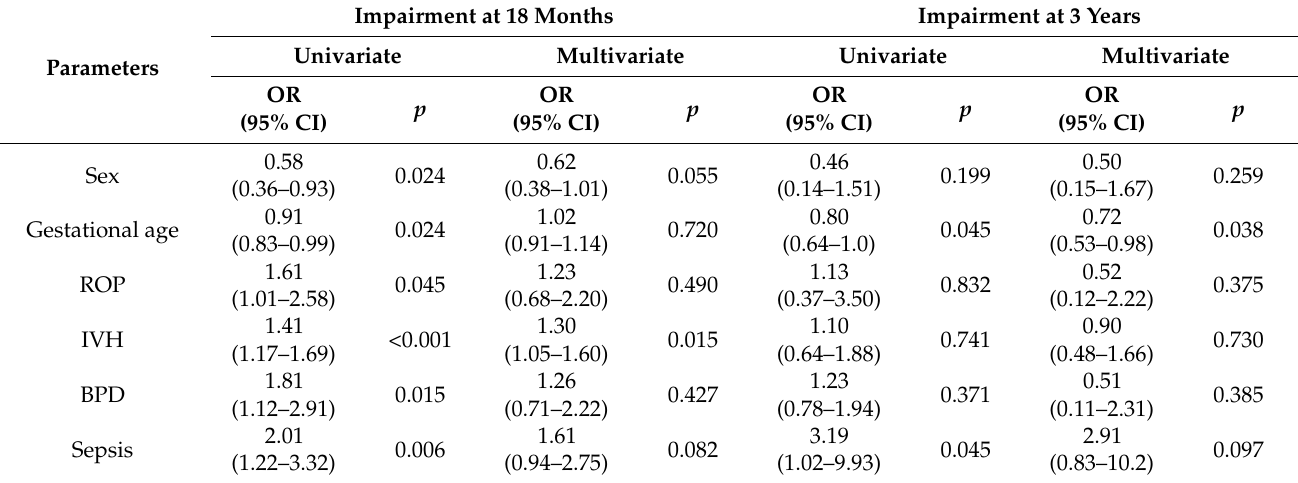
Table 3. Clinical factors associated with hearing impairment in univariate and multivariate regression analyses.